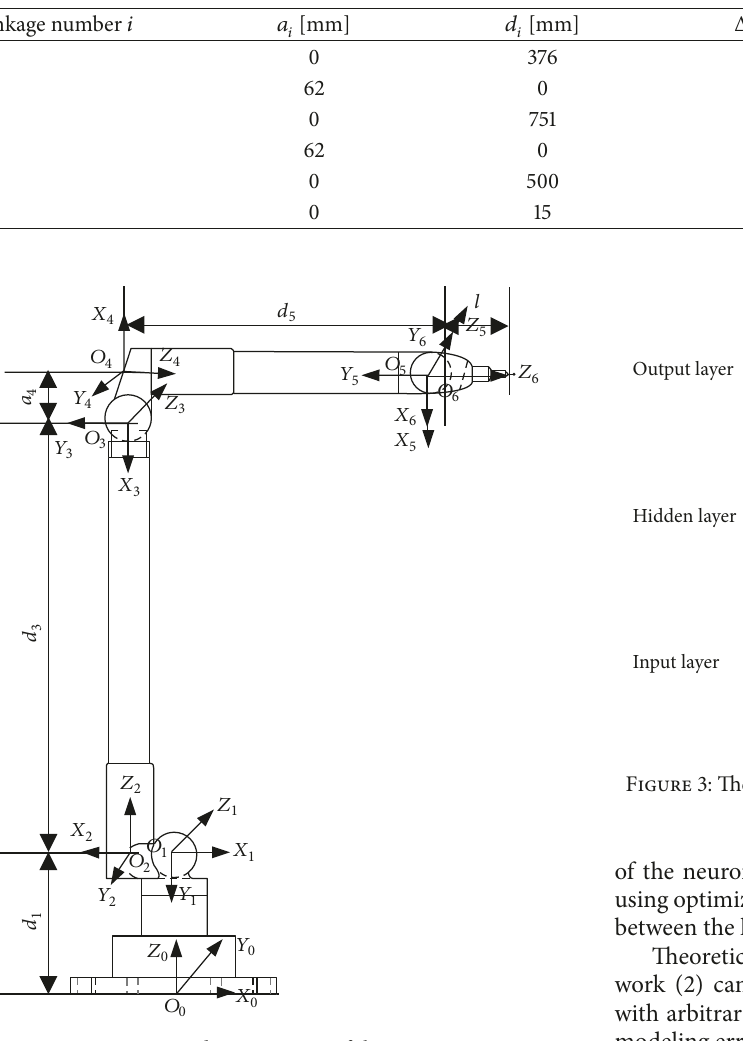
Figure 2: Coordinate systems of the AACMM.